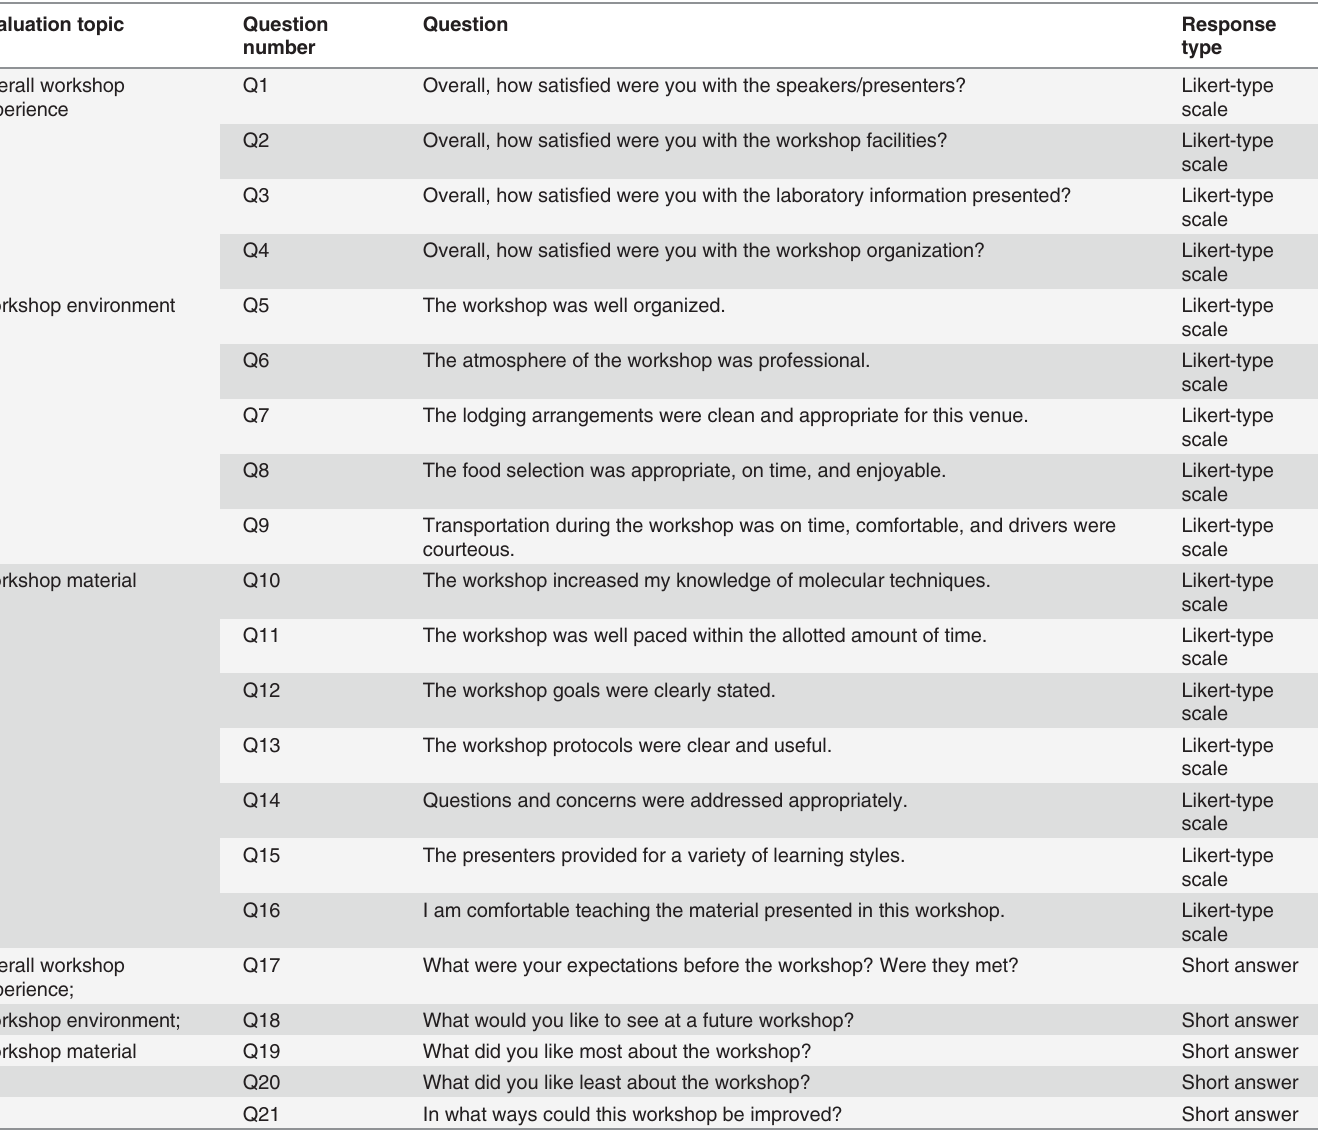
Table 1. Summary of questions on the written workshop